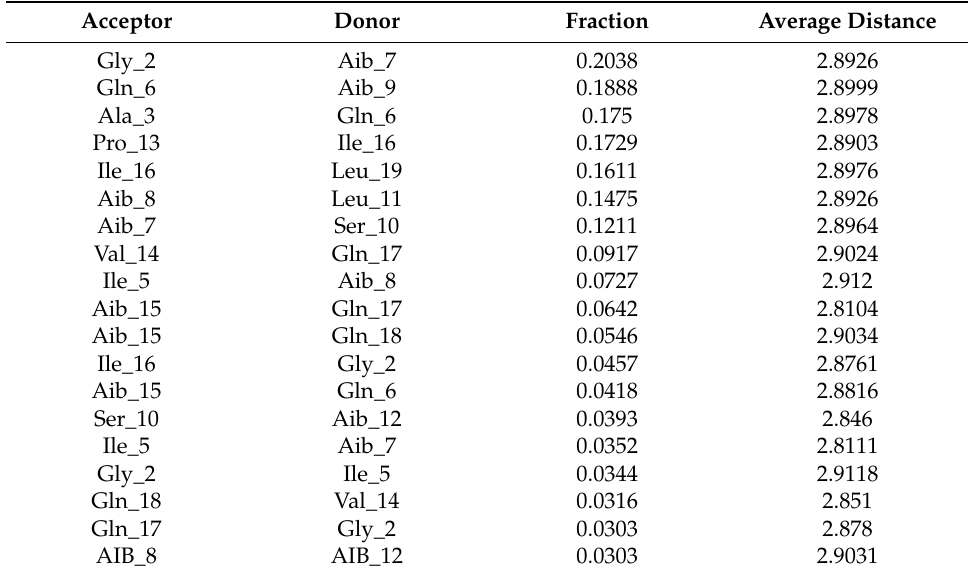
Table 3. Backbone H-bonds of Trikoningin KA V along with their frequency of occurrence given by fraction, average distance, and